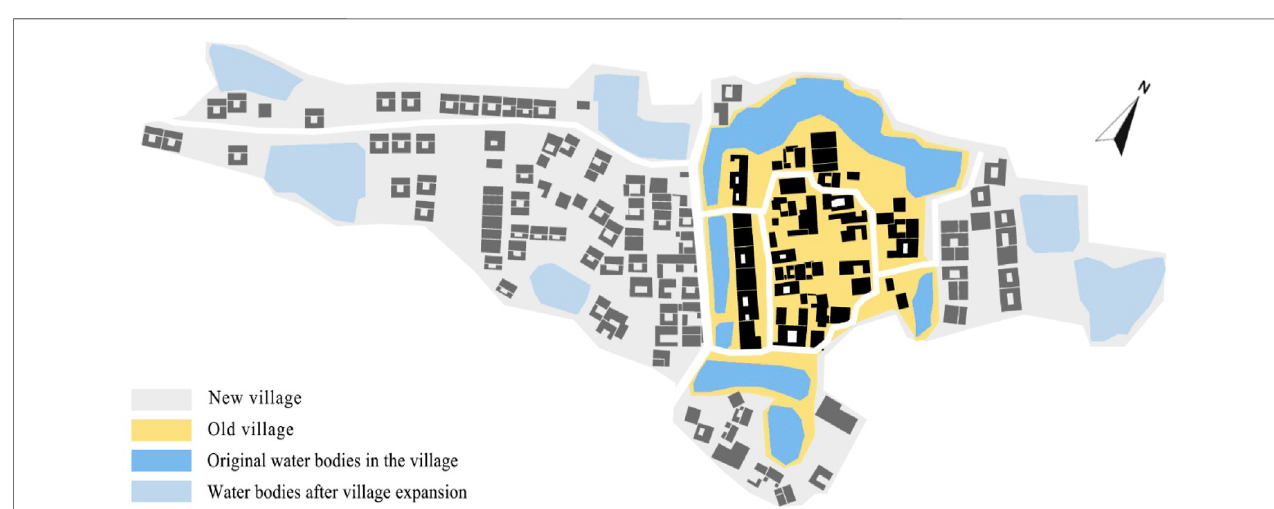
FIGURE 2 | Expansion from the old village to the new village with newly dug